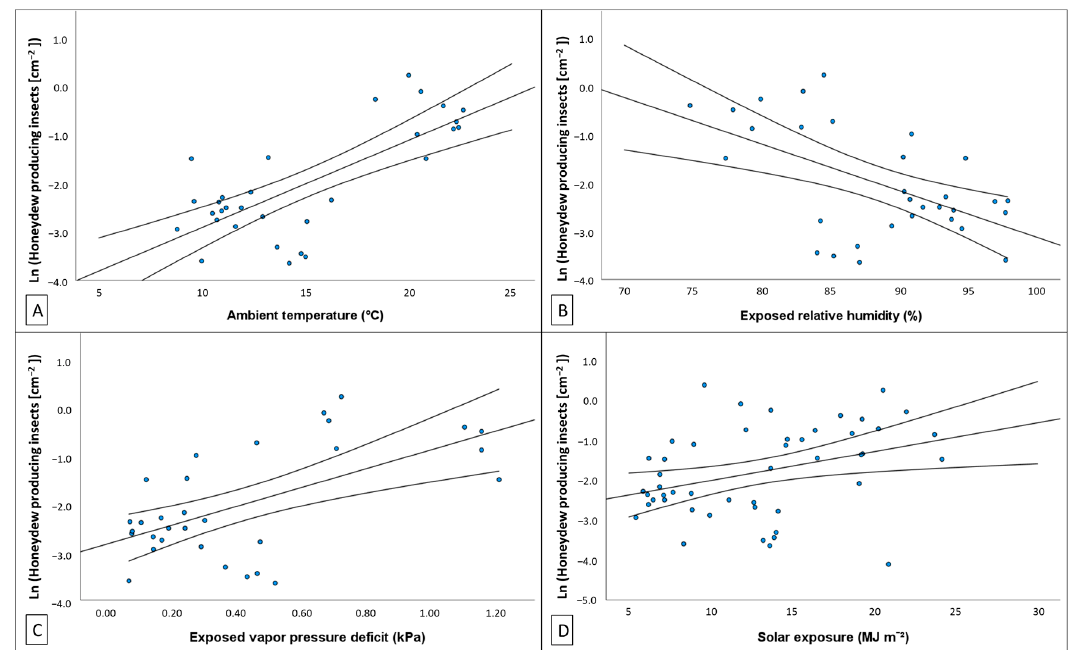
Figure 6. Relationship between natural log transformed fortnightly density of honeydew excreting nymphs (ln (HPI [cm − 2 ])) to ( A ) exposed temperature, ( B ) exposed relative humidity, ( C ) exposed vapor pressure deficit, and ( D ) solar exposure. Regression model is plotted as continuous black line, and curved lines indicate confidence intervals (95%) of the mean. Strong evidence was found that multiple climate variables correlate with, and explain, observed variation in ln (HPI [cm − 2 ]) (Table A11).